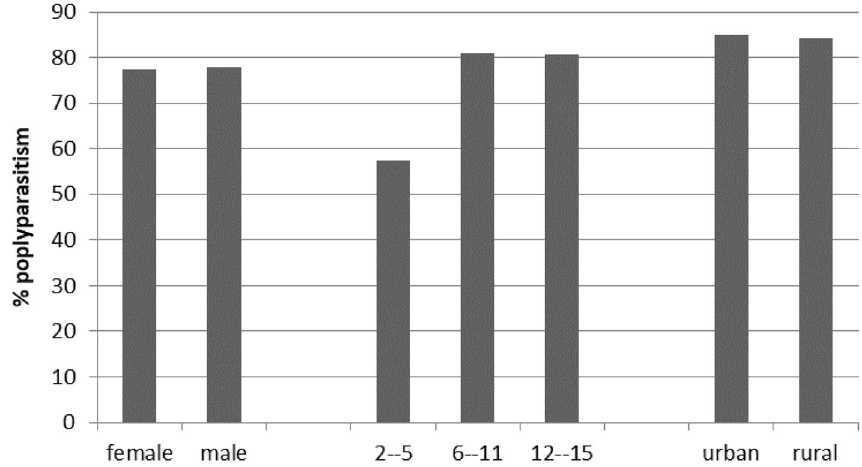
Figure 2. Polyparasitism obtained in R.A.A.N. according to sex, age group and urban/rural school area.